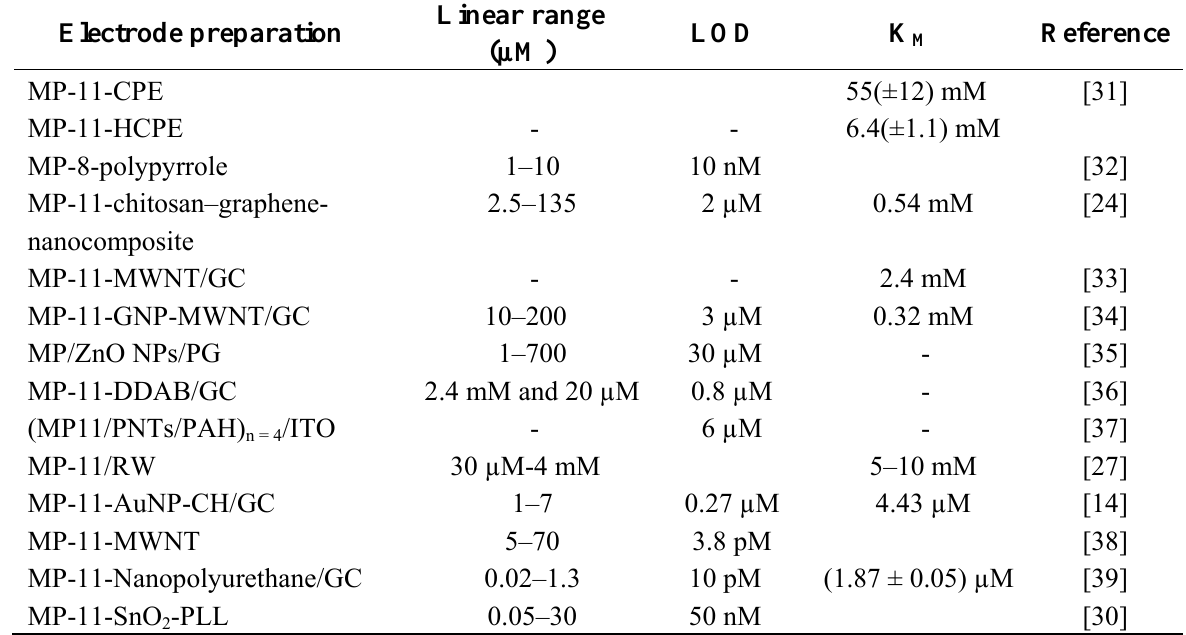
Table 1. Peroxide catalysis by MP-11 modified